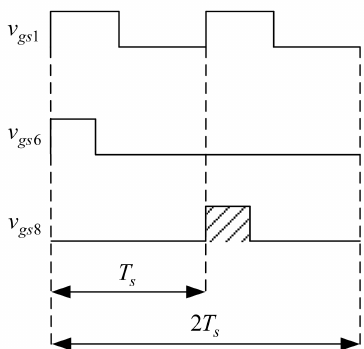
Figure 7. Two-phase switching period equal to double that of the main